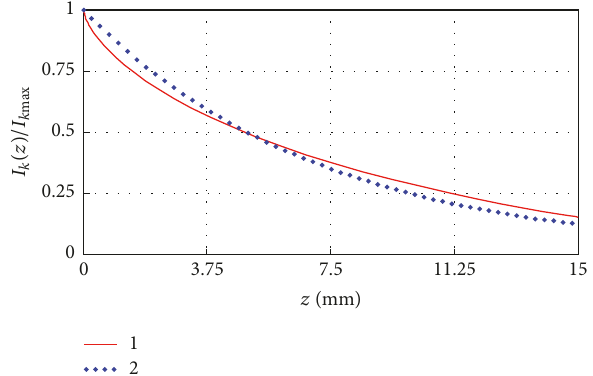
Figure 14: Dependence of the collector’s current on the depth of the electron beam’s interaction with the metal in the penetration channel. 1: theoretical curve and 2: curve based on experimental